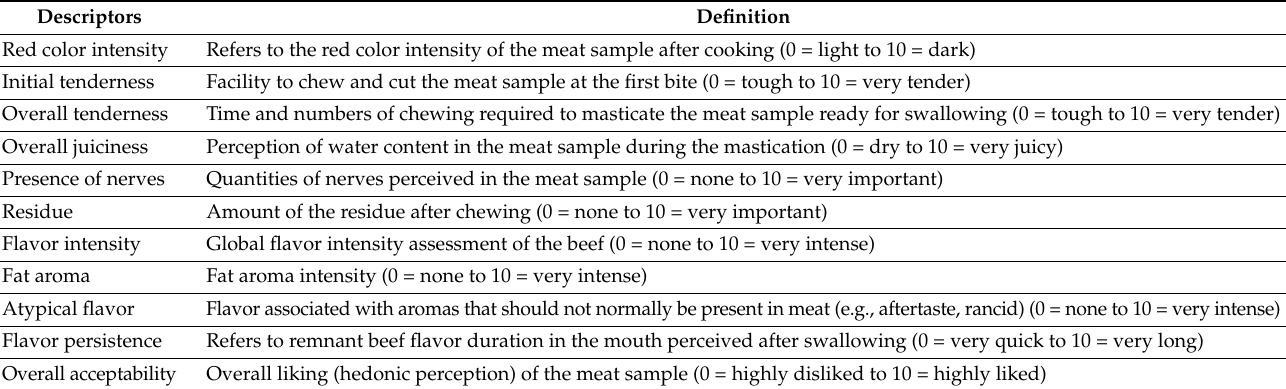
Table 5. Definitions of the sensory and hedonic